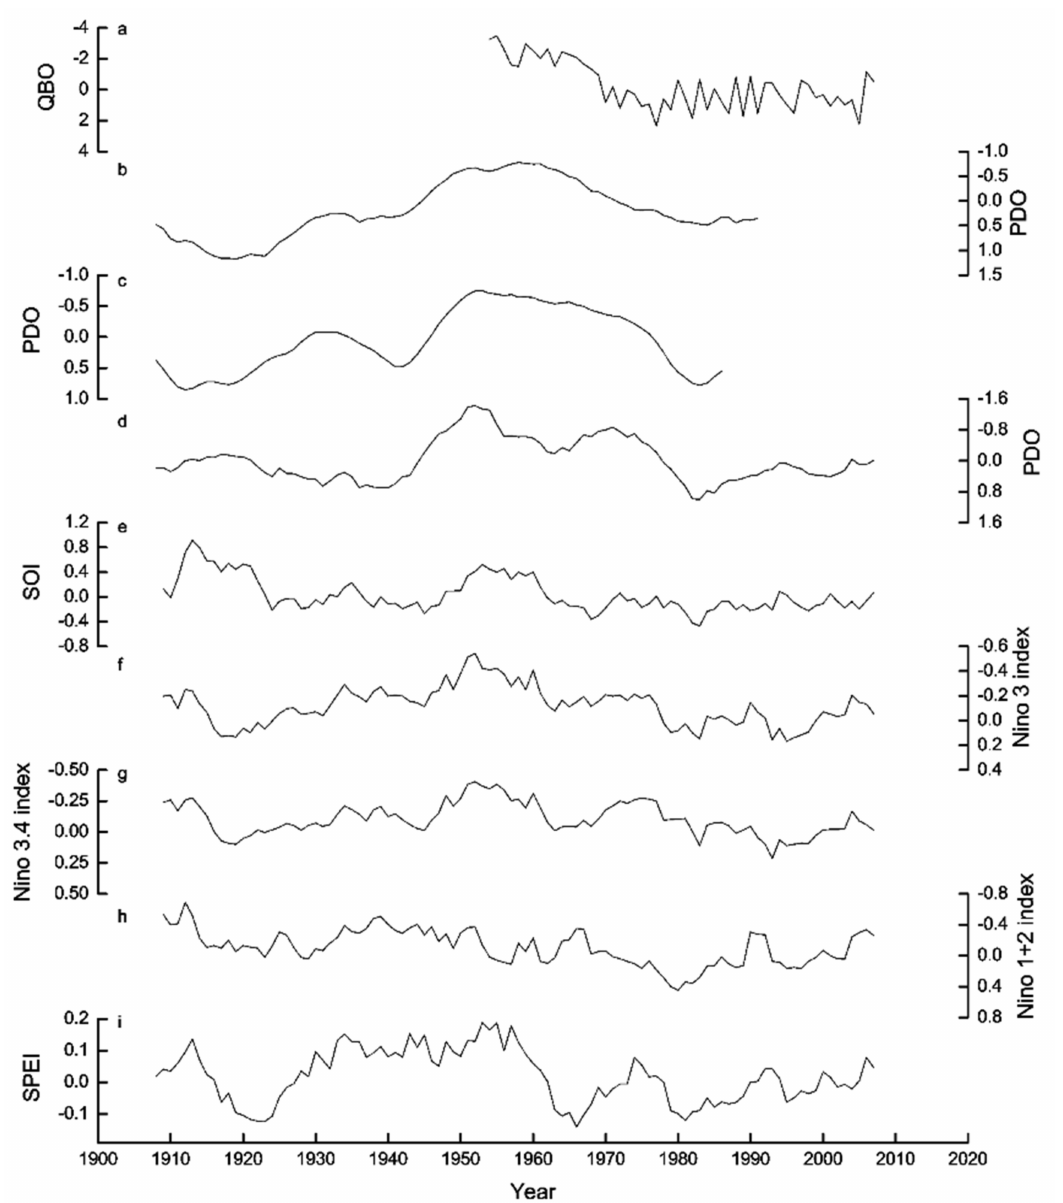
Figure 10. Comparisons with various climate proxies from the Pacific. ( a ) The QBO of from April of the previous year (https://psl.noaa.gov/data/correlation/qbo.data, accessed on 16 January 2022). ( b ) The annual PDO [63]. ( c ) The reconstructed PDO [62]. ( d ) The PDO from February of the current year (https://www.esrl.noaa.gov/psd/enso/data.html, accessed on 16 January 2022). ( e ) The